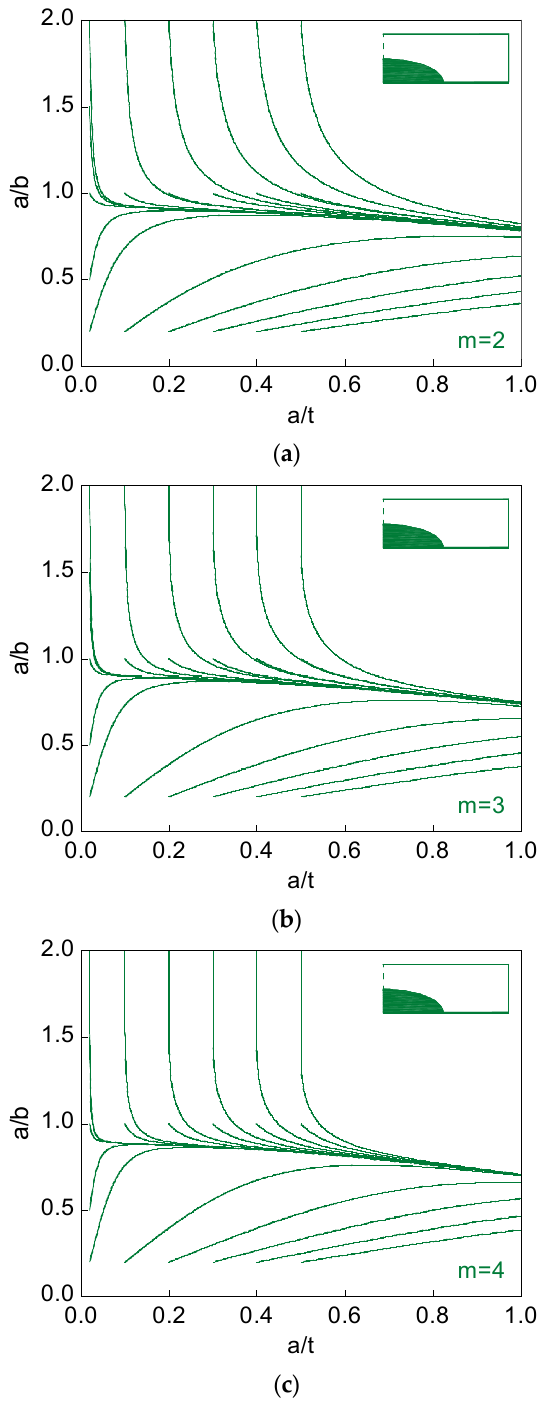
Figure 4. Aspect ratio evolution with relative crack depth (propagation path) for surface cracks: ( a ) m = 2; ( b ) m = 3; ( c ) m = 4.